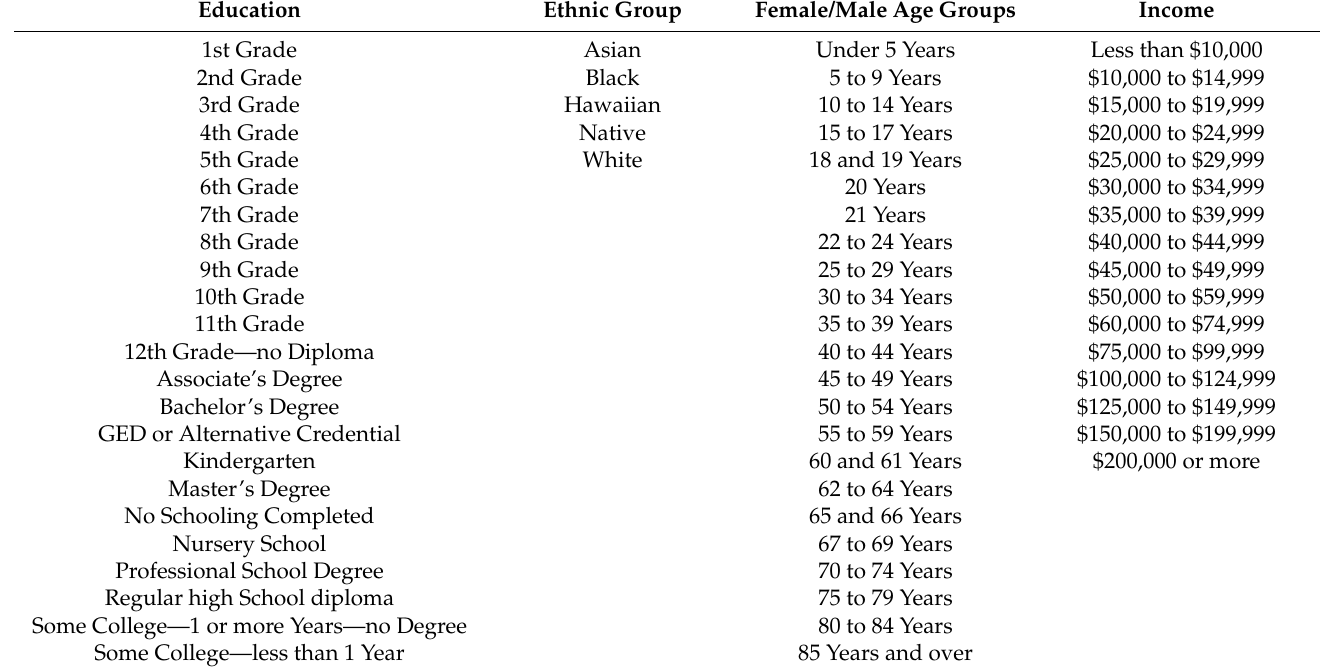
Table 2. Grouped overview over used demographic raster